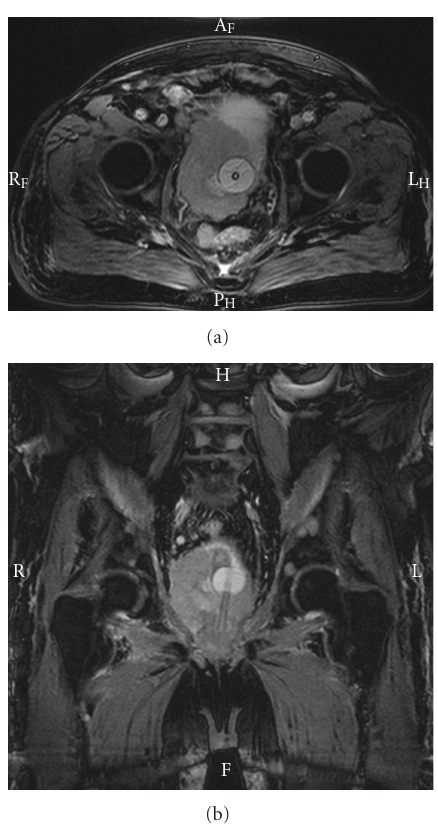
Figure 1: MRI demonstrating a local solid tumour with a diameter of 9cm infiltrating the trigone and the bladder floor on each